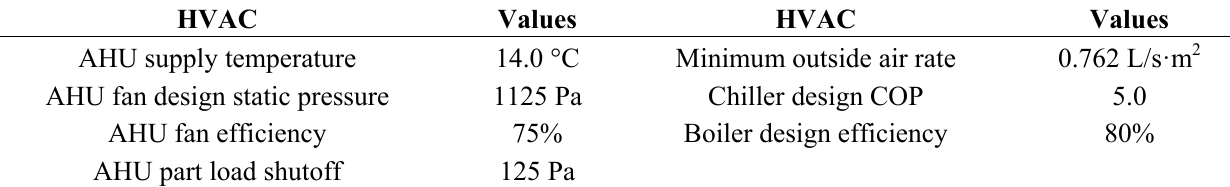
Table 2. HVAC system configuration.